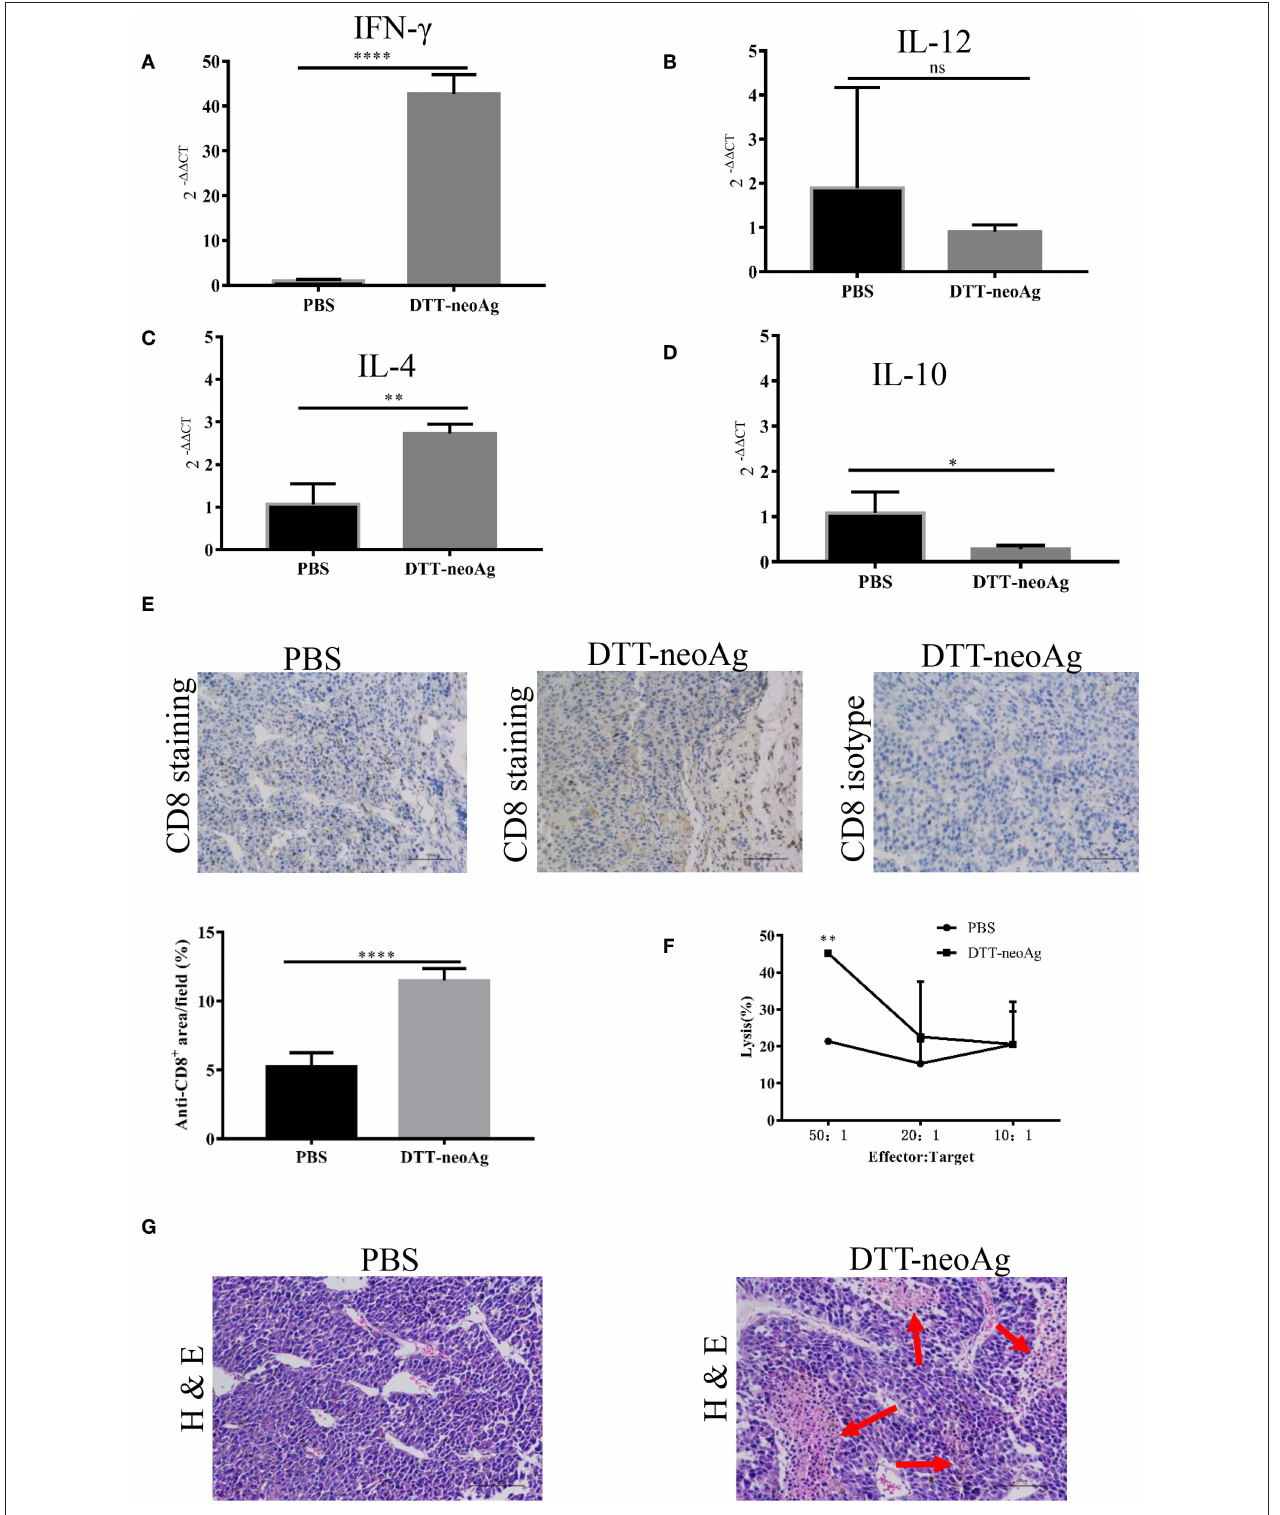
FIGURE 6 | DTT-neoAg vaccination increases tumor necrosis and enhances CD8 + T cells infiltration. The statistical significances were determined by Student’s T-test. **** P < 0.0001; *** P < 0.001; ** P < 0.01; * P < 0.05. Frozen sections of B16F10 tumor tissues isolated from mice immunized with DTT-neoAg or PBS as in Figure 3D . (A–D) The relative expression levels of IFN- γ , IL-12, IL-4, IL-10 in the tumor tissues were determined by RT-PCR, respectively. (E,G) B16F10 tumors from